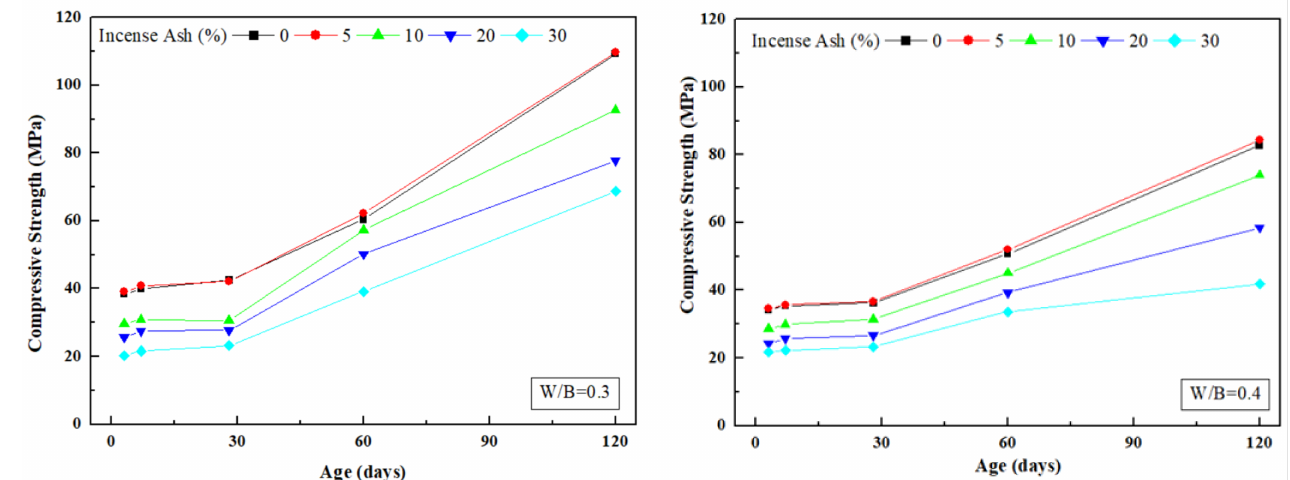
Figure 2. Compressive strength developments of incense ash paste (25 ◦ C).